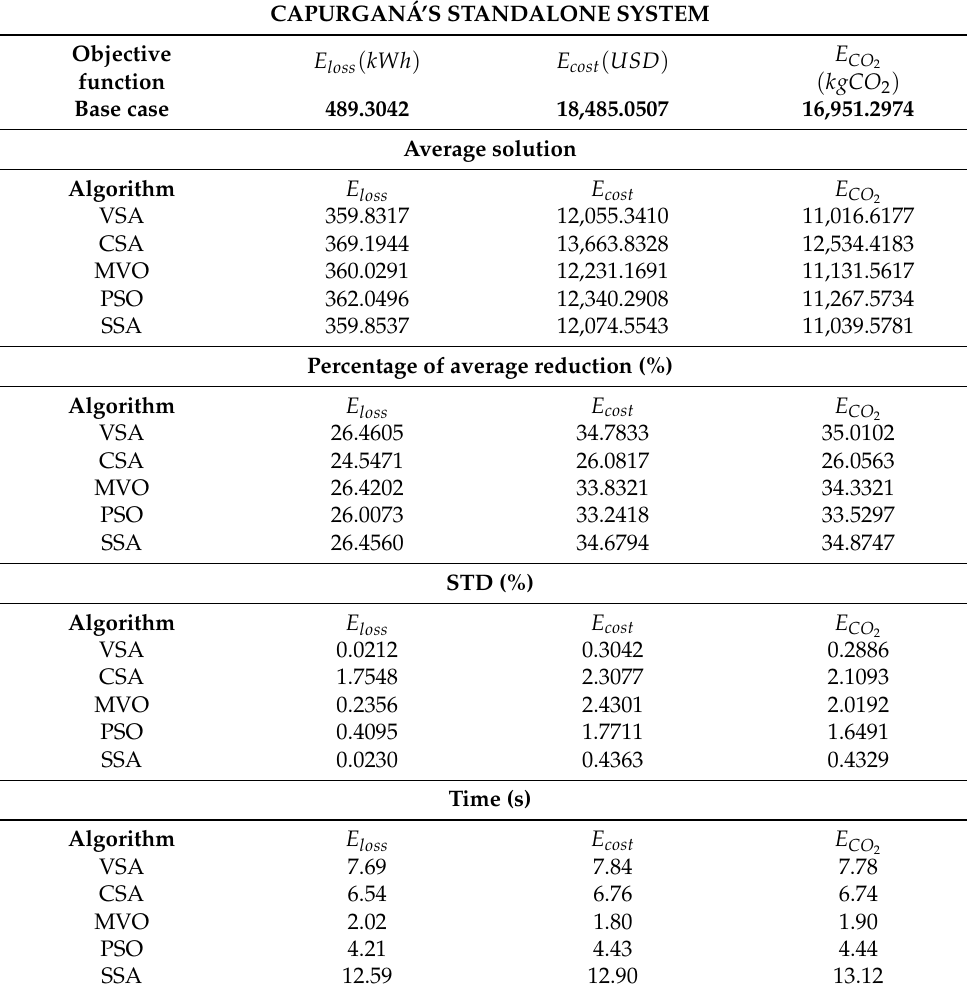
Table 9. Simulation results obtained by the optimization algorithms in standalone